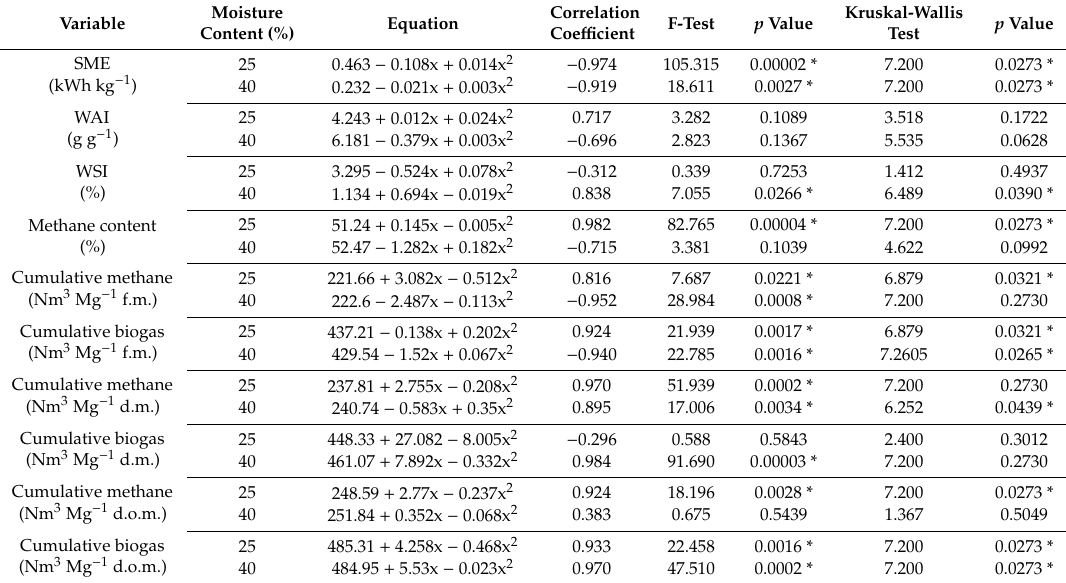
Table 1. Regression equations, correlation coe ffi cients and statistical one-way analysis of variance (ANOVA) with F-test and Kruskal-Wallis test depend on screw speed used during pretreatment of corn